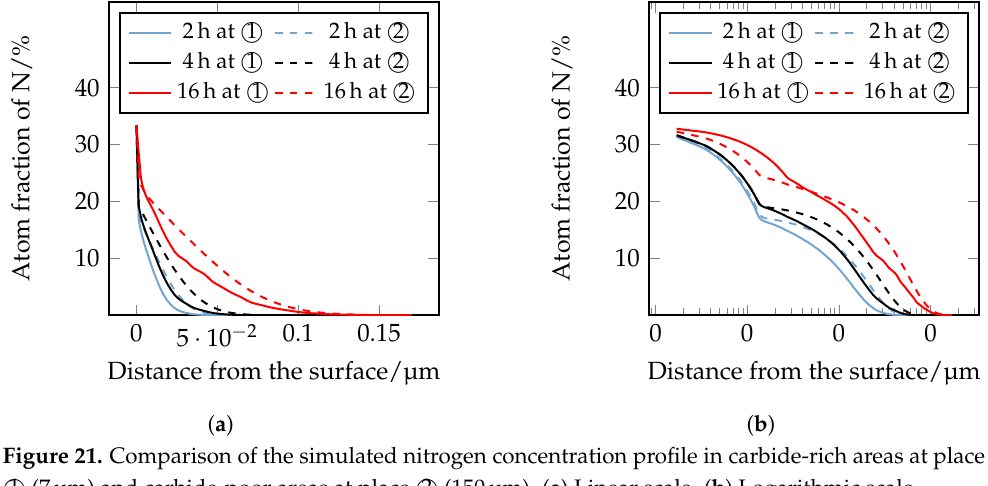
Figure 21. Comparison of the simulated nitrogen concentration profile in carbide-rich areas at place 1 (cid:13) (7µm) and carbide-poor areas at place 2 (cid:13) (150µm). ( a ) Linear scale. ( b ) Logarithmic